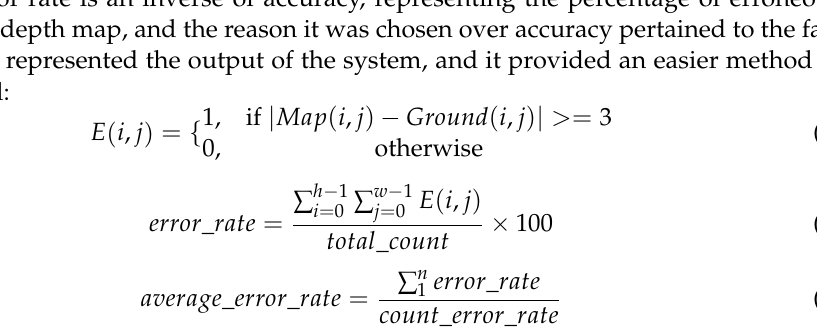
Table 2. Error rate for PyTorch and TensorFlow